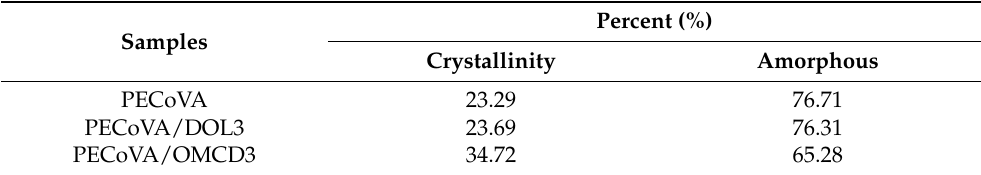
Table 4. Crystallinity of the virgin PECoVA, PECoVA/DOL3 and PECoVA/OMCD3 composites based on XRD analysis.